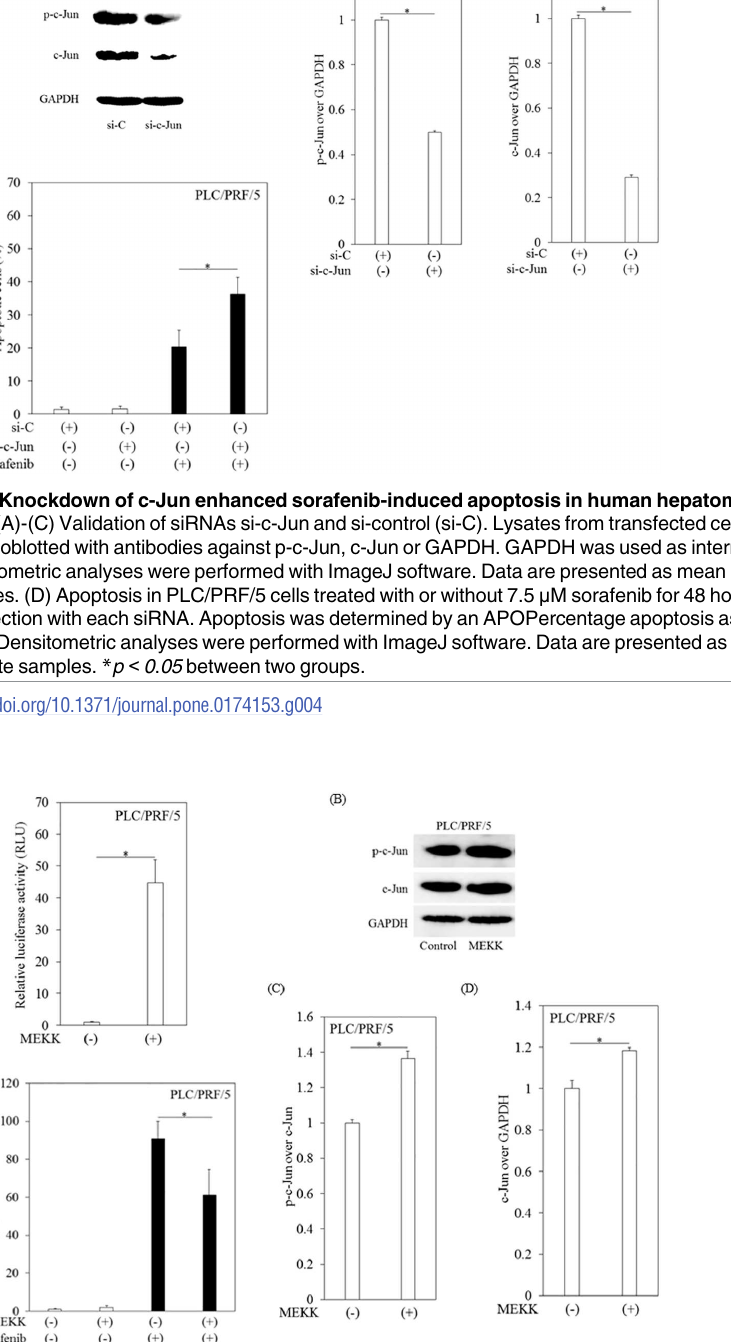
Fig 5. Overexpression of c-Jun by transfection of pMEKK impaired sorafenib-induced apoptosis in human hepatoma PLC/PRF/5 cells. (A) AP-1 activationfollowingthe transfectionof pMEKK into PLC/PRF/5 cells. (B)-(D) Phosphorylated-c-Jun (p-c-Jun) and expressionof c-Jun protein were enhanced by transfection of pMEKK into PLC/RPF/5 cells. Densitometric analyseswere performed with ImageJ software. (E) Apoptosis in PLC/PRF/5 cells treated with or without 10 μ M sorafenibfor 12 hours after transfectionof pMEKK or control vectors. The number of apoptotic cells was determinedby APOPercentage apoptosisassay (Biocolor). Data are presented as the mean ± SD of triplicate samples. * p < 0 . 05